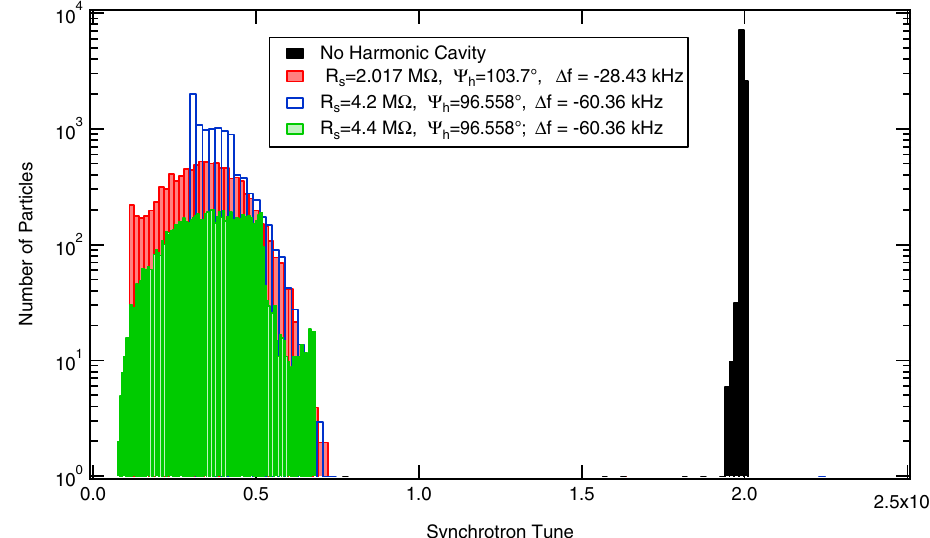
FIG. 6. Histogram of incoherent synchrotron tune distributions for different harmonic cavity settings. The tune distribution without harmonic cavities is shown for comparison.